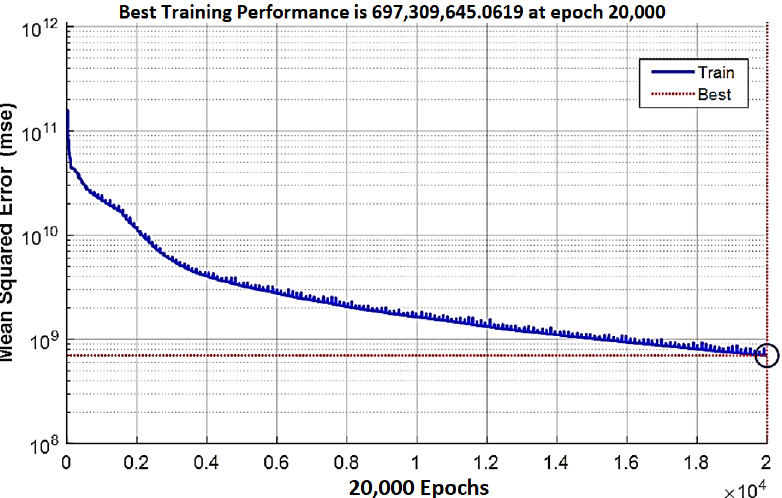
Figure 10. The mean squared error reduction history during the ANN training across all 377 elements in the region of interest.